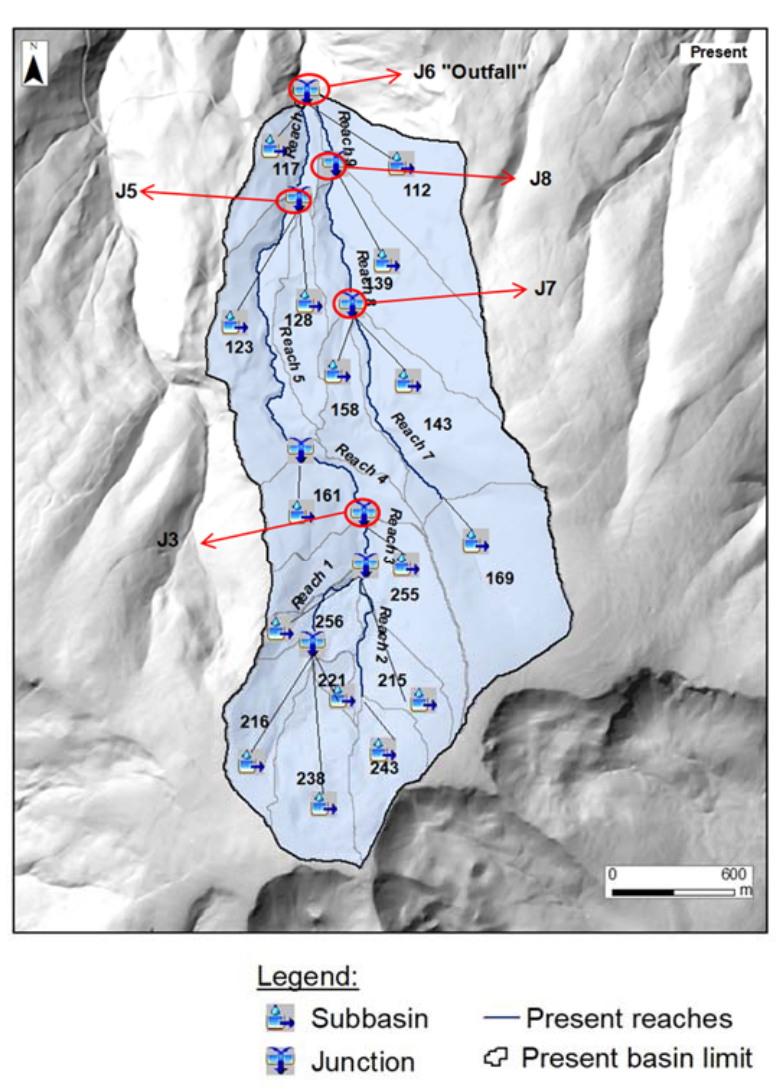
Figure 9. Portain é and Reguerals modelled basins and sub-basins using HEC-HMS software. The junctions or “control points” J3, J5, J6, J7, and J8 corresponding to Table 5 are highlighted.